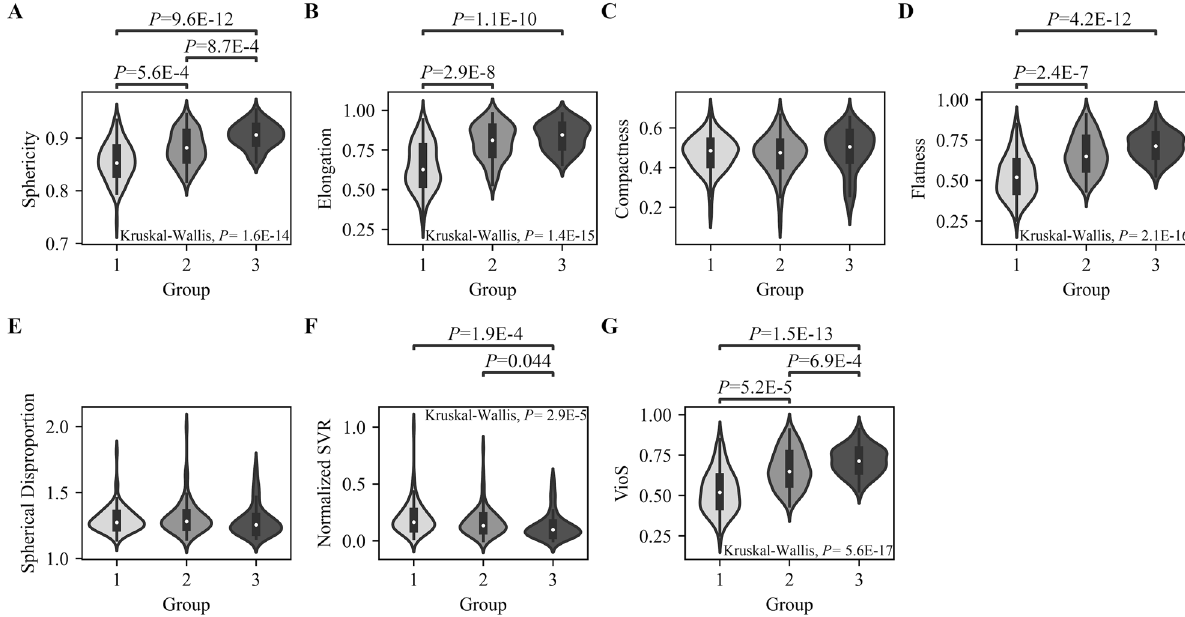
Figure 2. The violin plots outline the median value (white dot) and interquartile range (thick gray bar) of the shape irregularity features: ( A ) sphericity, ( B ) elongation, ( C ) compactness, ( D ) flatness, ( E ) spherical disproportion, ( F ) SVR N , and ( G ) VioS for different TV subgroups. The P -values were Bonferroni adjusted and obtained using a Kruskal–Wallis test followed by Dunn’s post-hoc test.